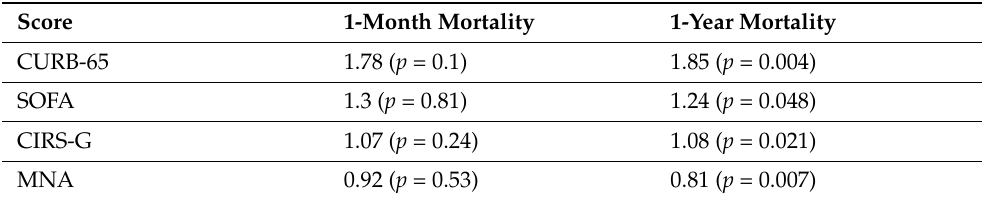
Table A4. Association between pneumonia/sepsis severity scores and scores evaluating comorbidi- ties, malnutrition and functionality, and 1-month and 1-year mortality. Results are expressed as odds ratios